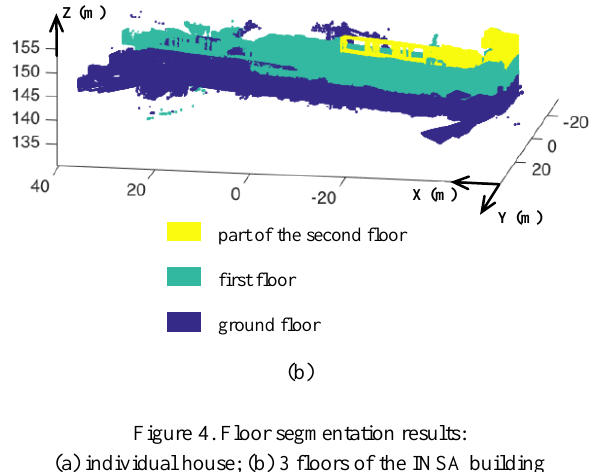
Figure 5. Image creation and 2D segmentation: (a) slice of point clouds at ceiling level; (b) generated image; (c) result obtained after region growing (one colour per detected region) 5.2 From 2D to 3D regions In order to move from 2D to 3D regions representing the rooms, the distances between 2D regions and the floor points are computed. For each 2D region, the 2D Euclidian distances between points of the floor and the corresponding nearest point in the region are determined. Figure 6 shows a part of a 2D region in dark blue superimposed with the floor points projected in 2D in red. The 2D distances between red points and the corresponding nearest dark blue point are determined. If these distances are lower than a predefined threshold, the points are assigned to the region. A threshold of 5 cm was chosen based on the pixel size of 3 cm.